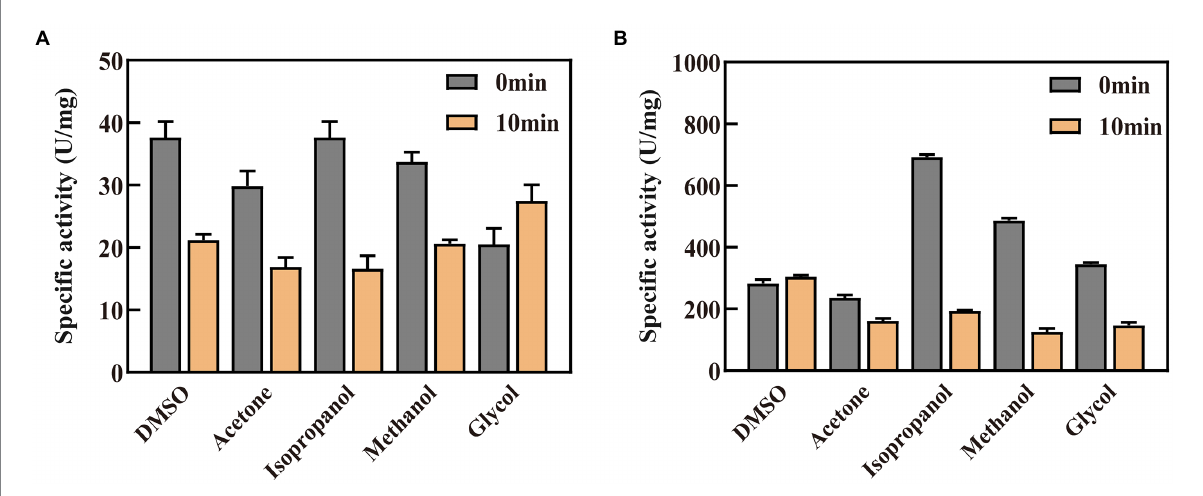
FIGURE 6 Effect of organic solvents on the catalytic activity and stability of GDH and P45A. (A) Effect of organic solvents on GDH. (B) Effect of organic solvents on P45A. A final concentration of 10% (V/V) organic solvent was added into the enzyme solution. The residual enzyme activity was detected when the enzyme was kept in the solution for 0 or 10 min. The results are expressed as the mean ± SD ( n = 3).